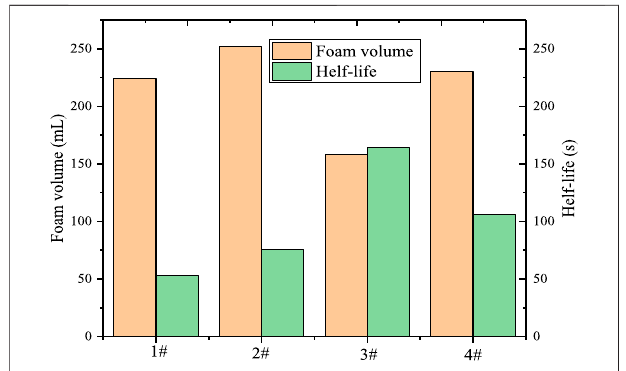
FIGURE 8 | Foaming volume and half-life of viscosity